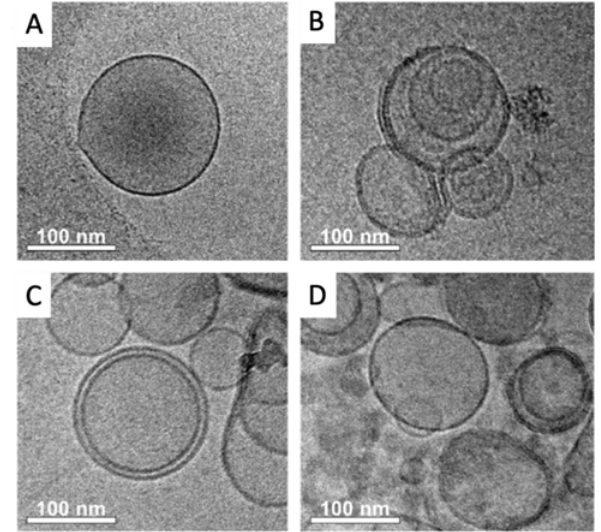
Figure 5. Cryogenic transmission electron microscopy (Cryo ‐ TEM) on purified exosomes derived from ( A , B ) MCF ‐ 7, ( C ) MDA ‐ MB ‐ 231 and ( D ) SKBr3 breast cancer cell lines.